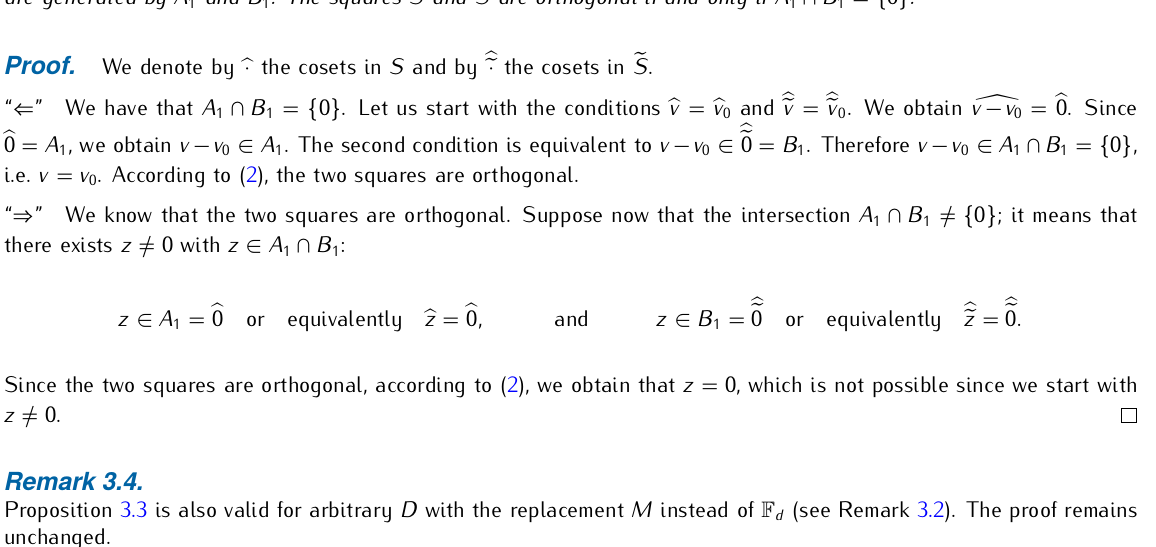
(cid:0) µ 2 ,µ 2 (cid:1)(cid:9) , b) A , , 1) + A 2 = (0 1